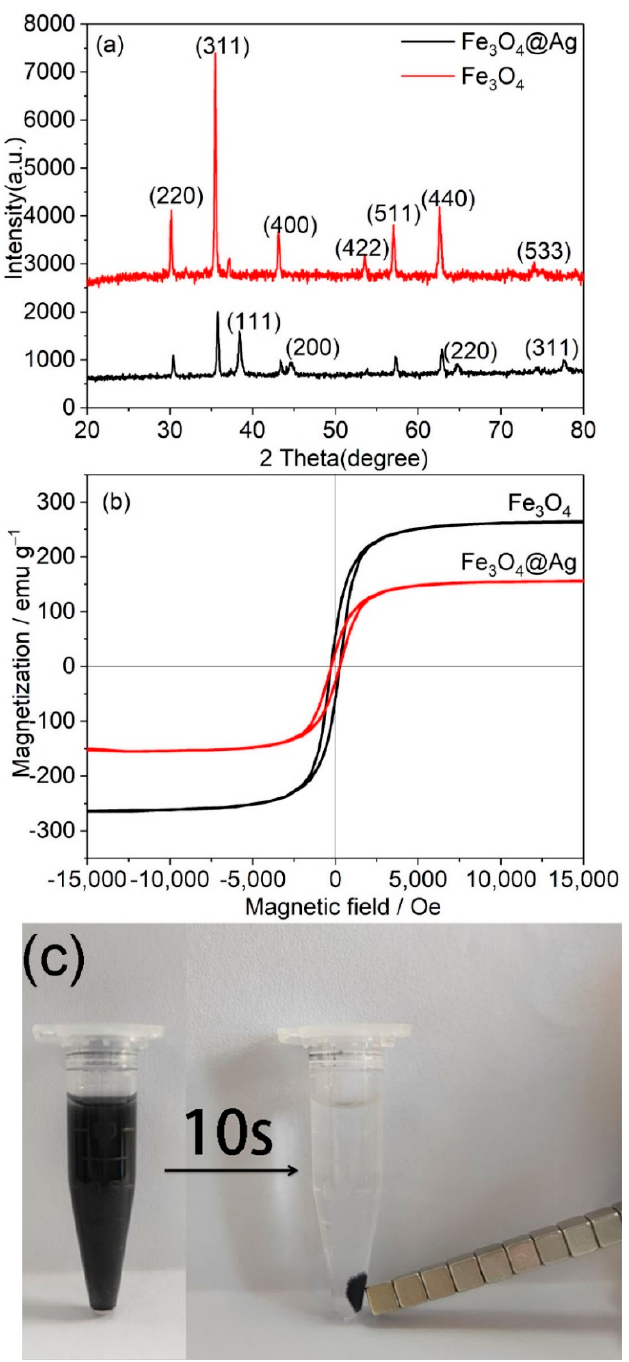
Figure 3. ( a ) XRD patterns of Fe 3 O 4 and AgMNPs. ( b ) Magnetic hysteresis curves of Fe 3 O 4 and AgMNPs and ( c ) the separation property of AgMNPs under an applied magnetic field.